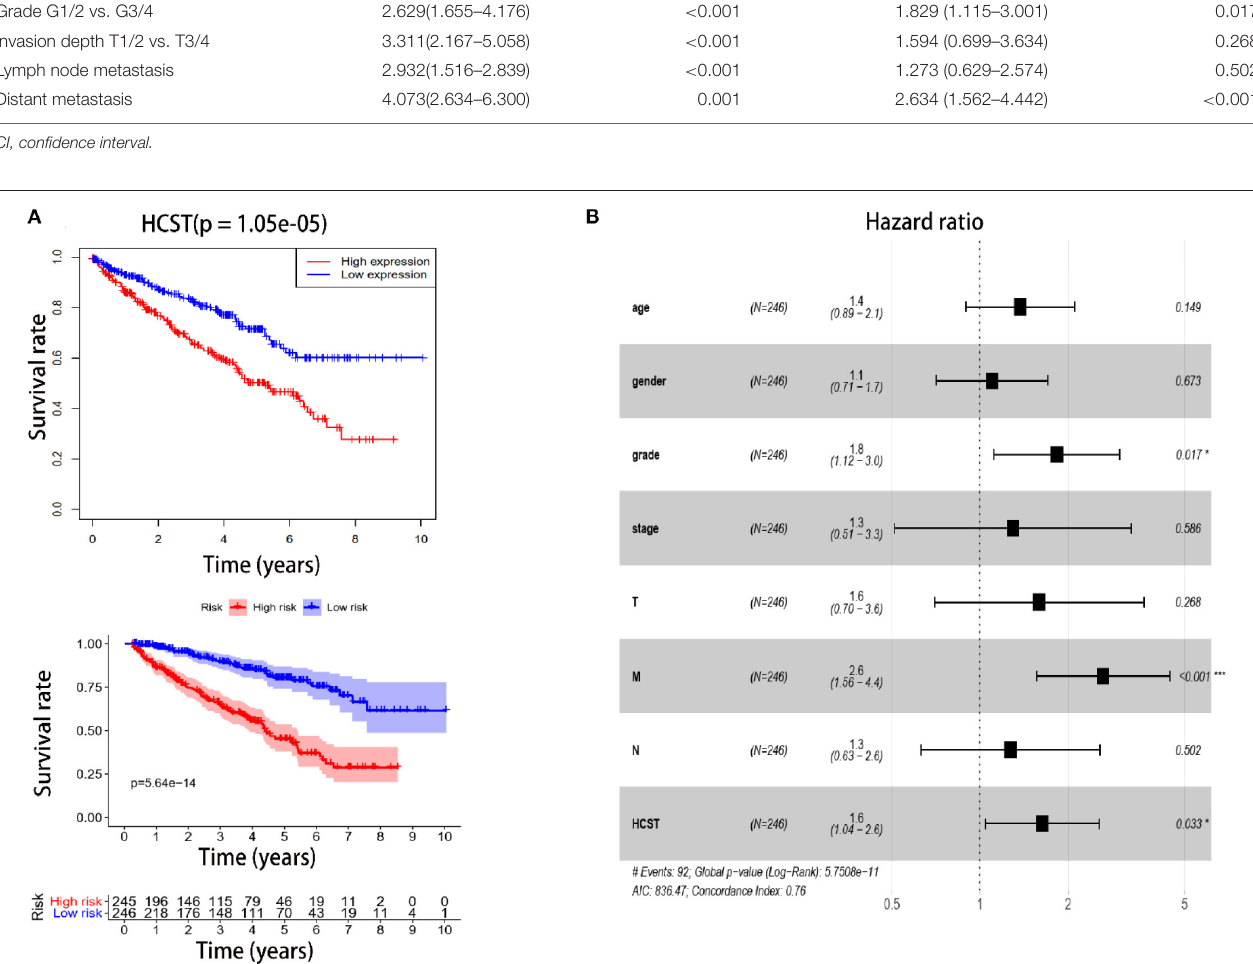
Frontiers in Oncology |